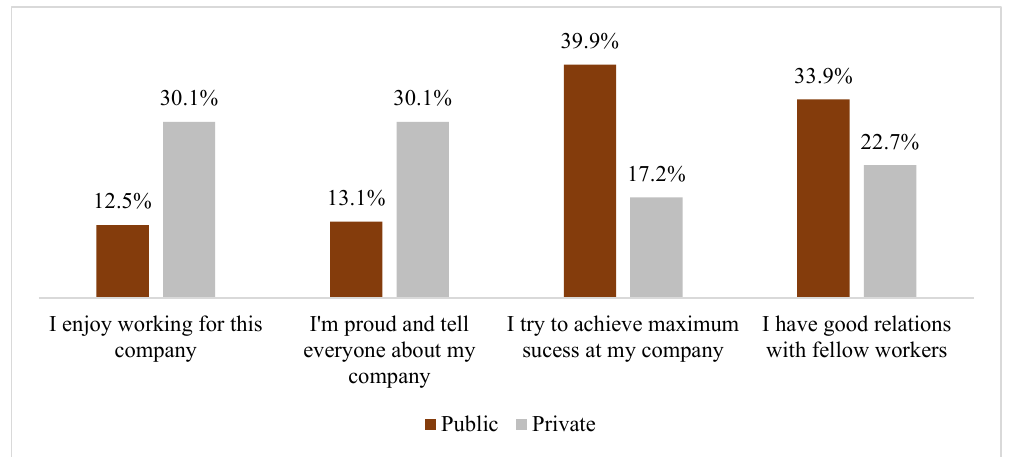
Fig. 2. Motivation from managers. Source: The authors’ calculations.